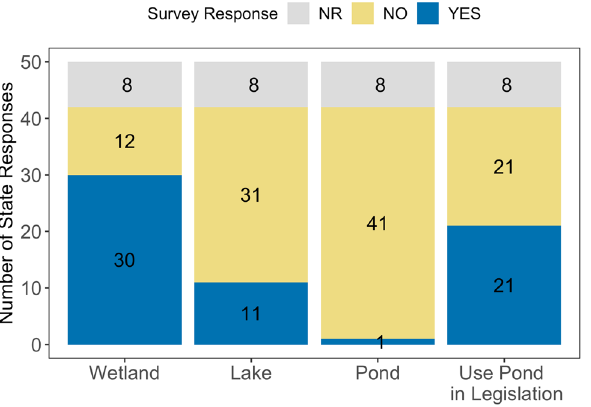
Figure 3. US state responses to surveys indicating if the state has a definition of wetland, lake, or pond and if the state used the term “pond” in their legislation. NR = no